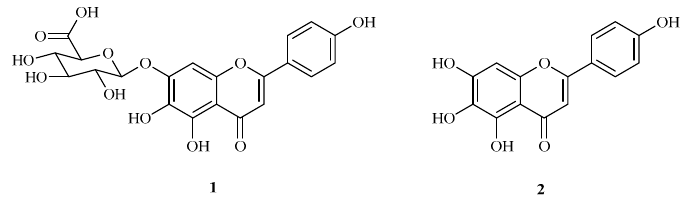
Figure 1. Structures of scutellarin ( 1 ) and scutellarein ( 2 ).